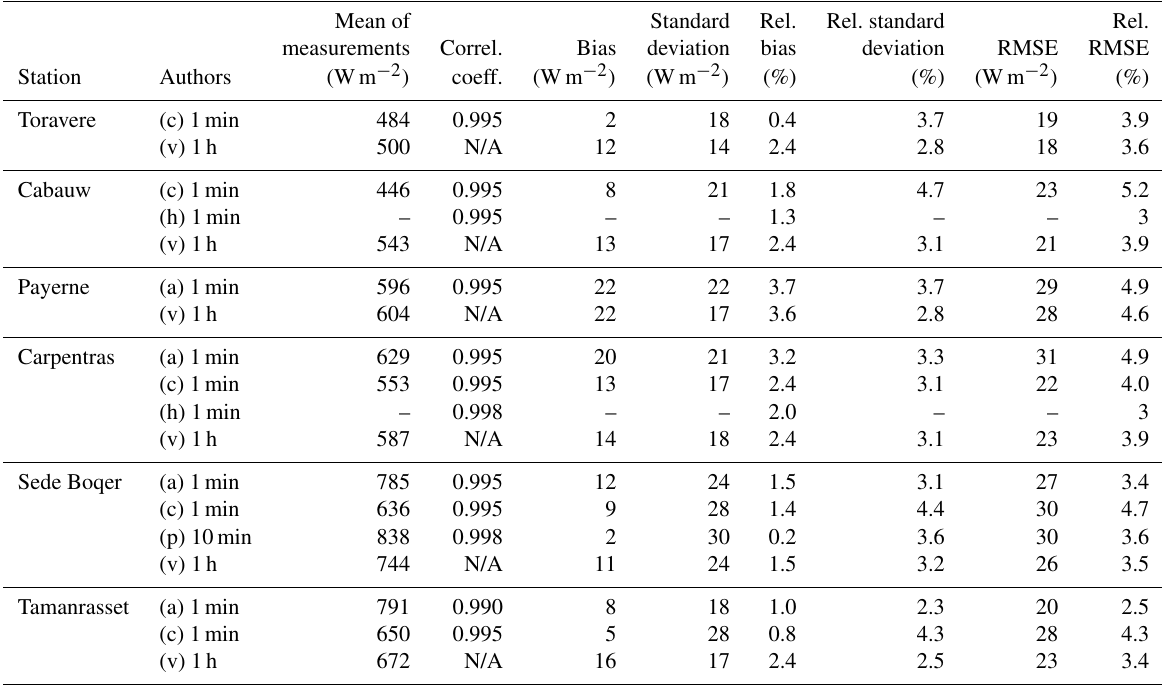
Table 15. Comparison of results obtained for G at different summarizations at the same station. N/A: not available. Mean of Standard Rel. Rel. standard Rel. measurements Correl. Bias deviation bias deviation RMSE RMSE Station Authors (Wm − 2 ) coeff.